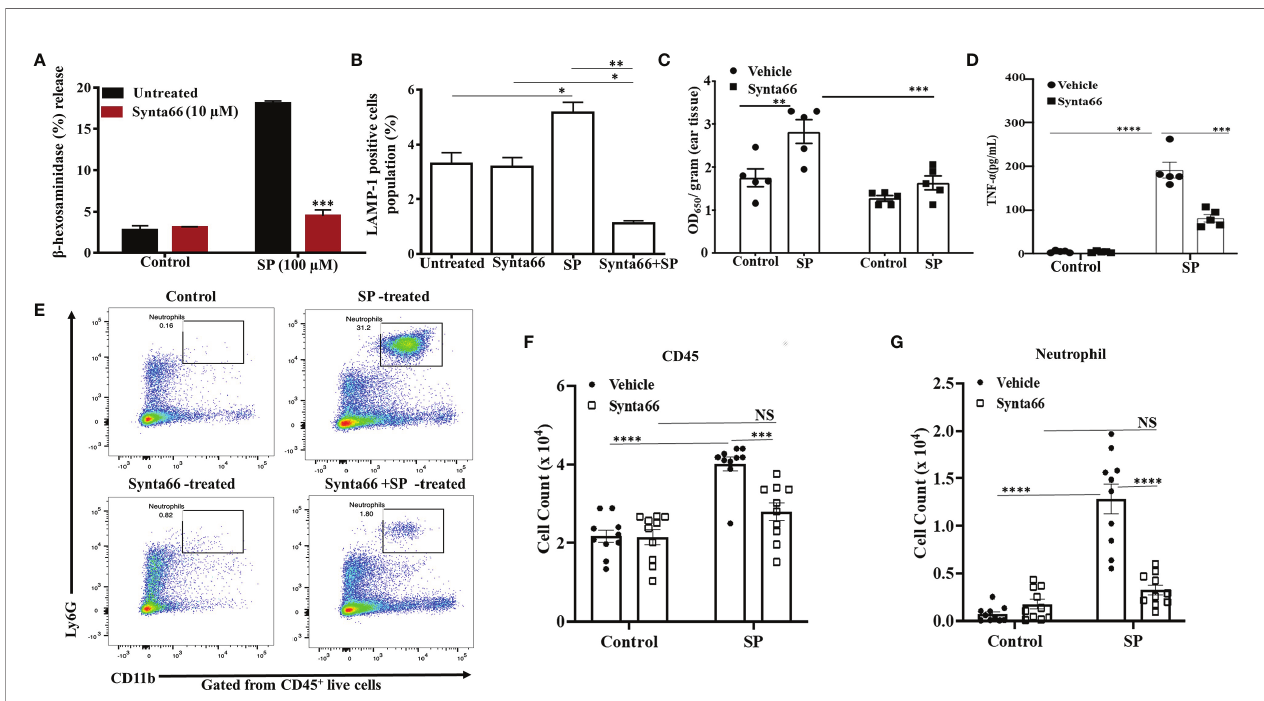
FIGURE 5 | Synta66 Attenuates SP-Induced Murine MC Responses in vitro and in vivo . SP-induced (A) b -hexosaminidase release (N = 4) and (B) LAMP-1 expression as determined by fl ow cytometry on PMCs (N = 3). (C) Synta66 or vehicle was administered via i.p. injection prior to SP injection in one ear and the buffer control in the other. Vascular permeability was quanti fi ed by measuring Evans blue extravasation. Synta66-treated or untreated mice were injected (i.p) with SP. After 3 h, blood and peritoneal lavage fl uid was collected (N = 5). (D) Serum TNF- a was determined by ELISA, N = 5. (E) Representative FACS images showing neutrophil recruitment and numbers indicate the percentage of CD45 + CD11b + Ly6G + live cells in peritoneal cavity. The absolute number of immune cells was calculated from the fl ow cytometry pro fi le for each mouse based on gated (50,000 cells) population (F) Total CD45 + cells, and (G) Total neutrophil counts. Data presented are mean ± SEM of N = 10. Statistical signi fi cance was determined by two-way ANOVA with Sidak ’ s multiple comparisons at a value ****p < 0.0001, ***p < 0.001, **p < 0.01, *p < 0.05 and NS, “ not signi fi cant ”